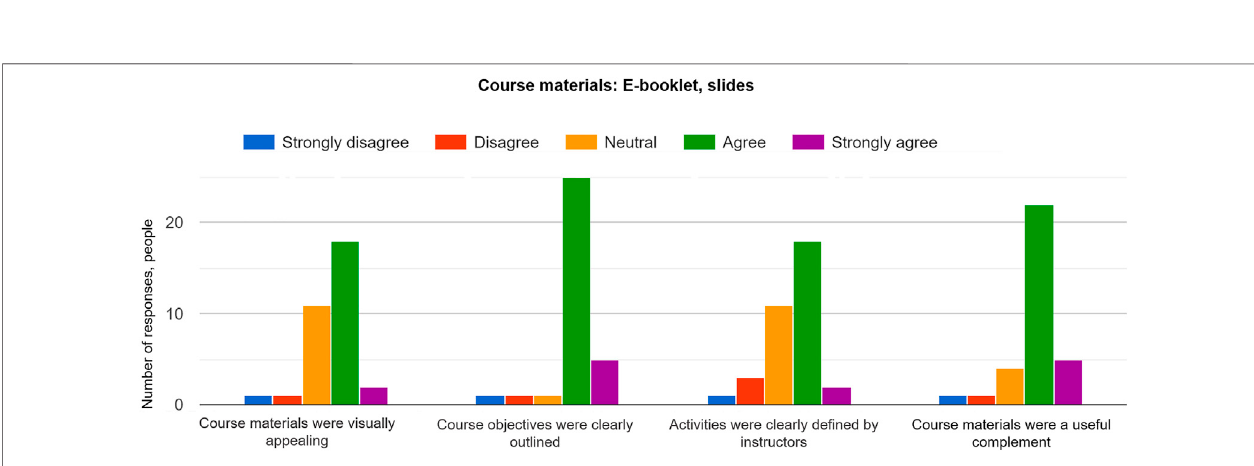
FIGURE6 | Responses of participants for evaluation ofthe course materials, such as e-booklet and slides. All the course activitieswere described inthe e-booklet provided on the short course day.